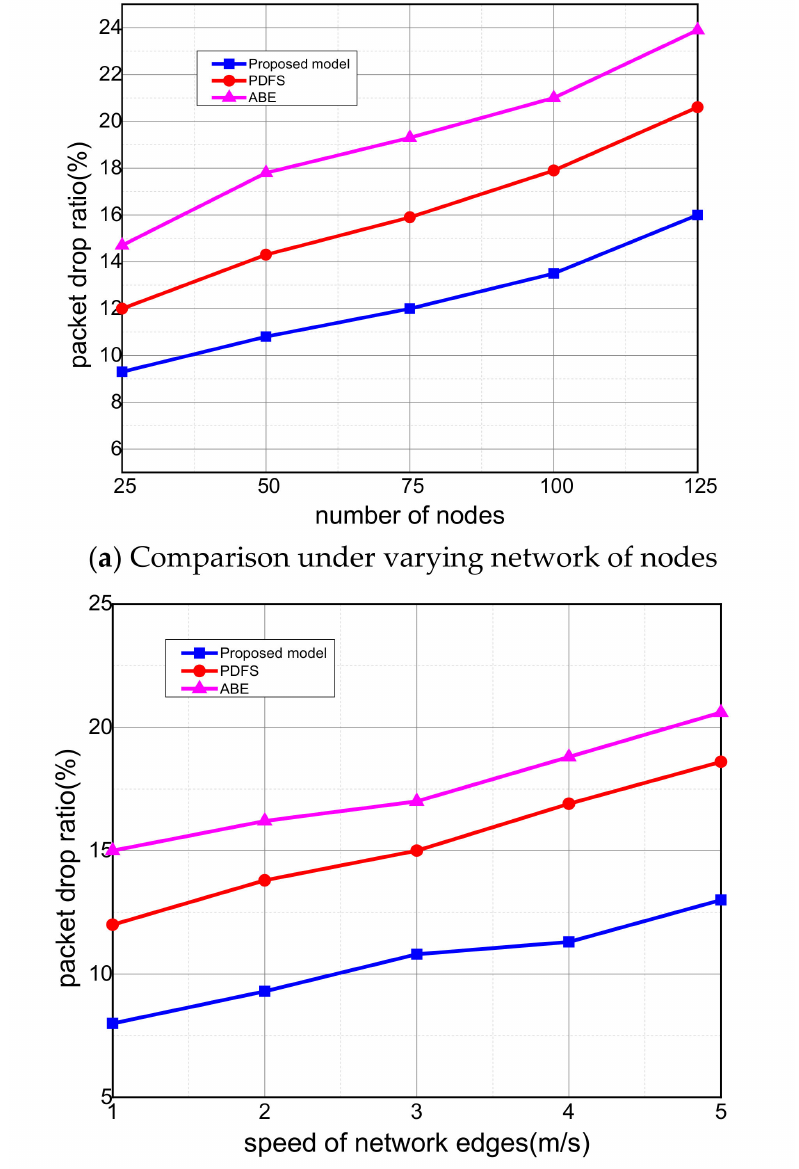
Figure 4. Evaluation of packet drop ratio among proposed model, PDFS,